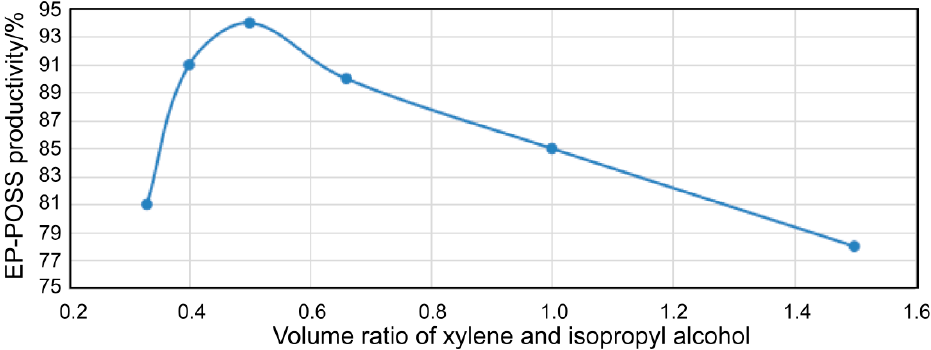
Figure 2. A curve relating the xylene/isopropanol volume ratio with the EP-POSS yield.